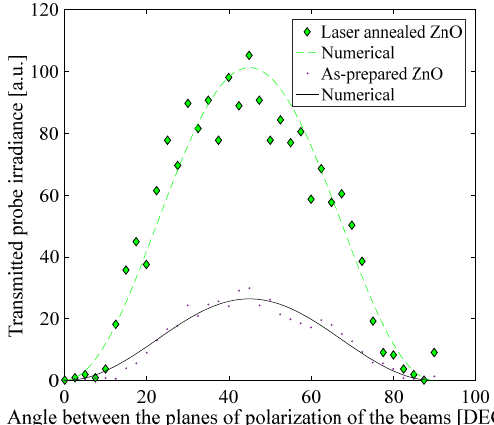
Figure 2. Nanosecond probe transmittance vs. angle of polarization of the interacting beams in the thin films studied.